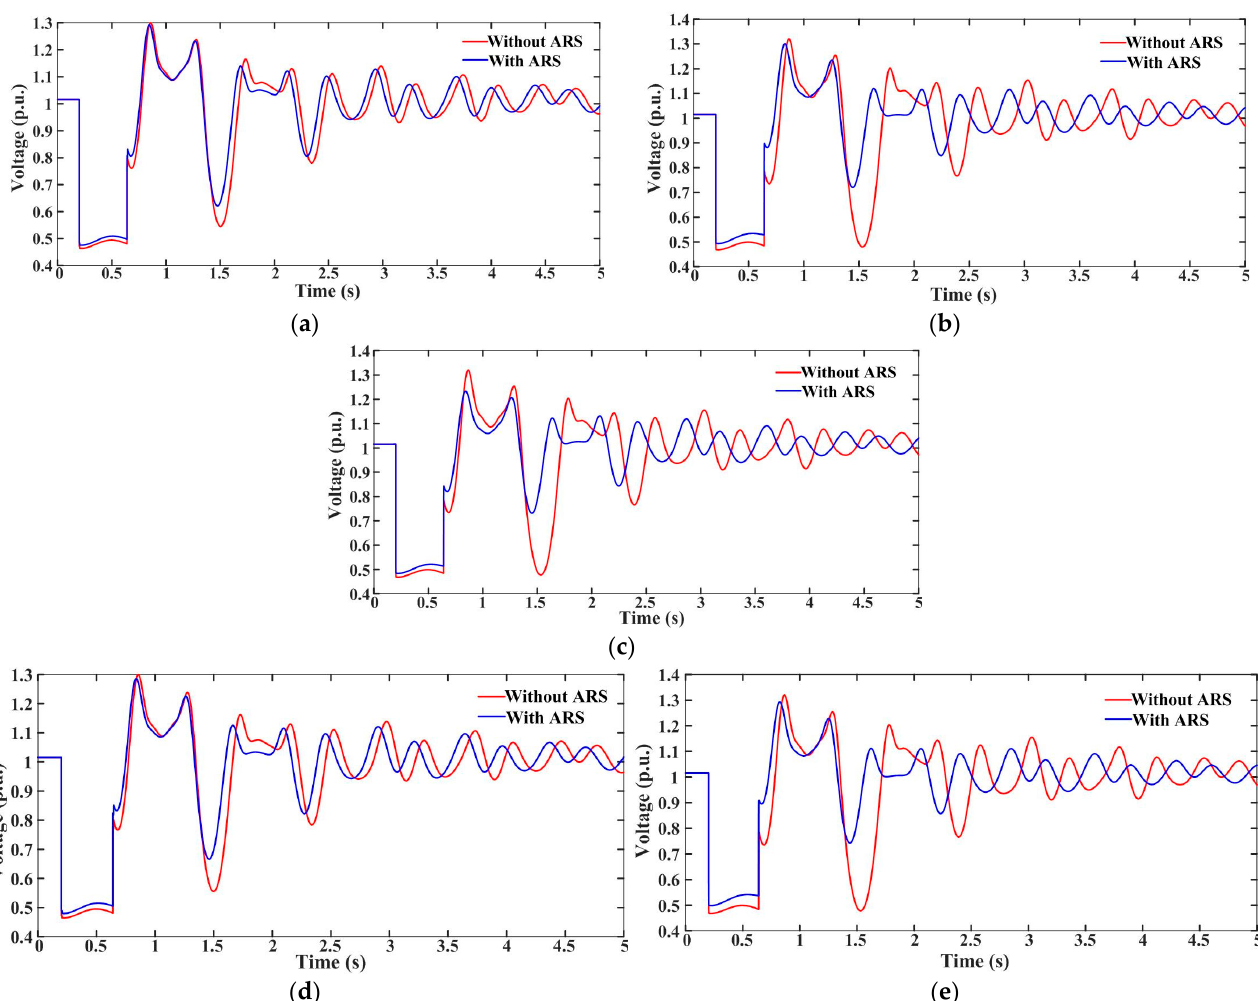
Figure 9. Variations in system voltage at bus 8 when connected to: ( a ) a wind farm with a DFIG; ( b ) a wind farm with a PMSG; ( c ) a solar PV farm; ( d ) a combination of a wind farm with a DFIG and a solar PV farm; and ( e ) a combination of a wind farm with a DFIG and a solar PV farm. The reactive power support given by the DFIG wind farm during the fault period is less compared to the PMSG wind farm with proposed control because of the low rating of the DFIG grid-side converter which is shown in Figure 10. Figure 10 clarifies that the re- active power supplied to the system during fault is larger when the combination of the